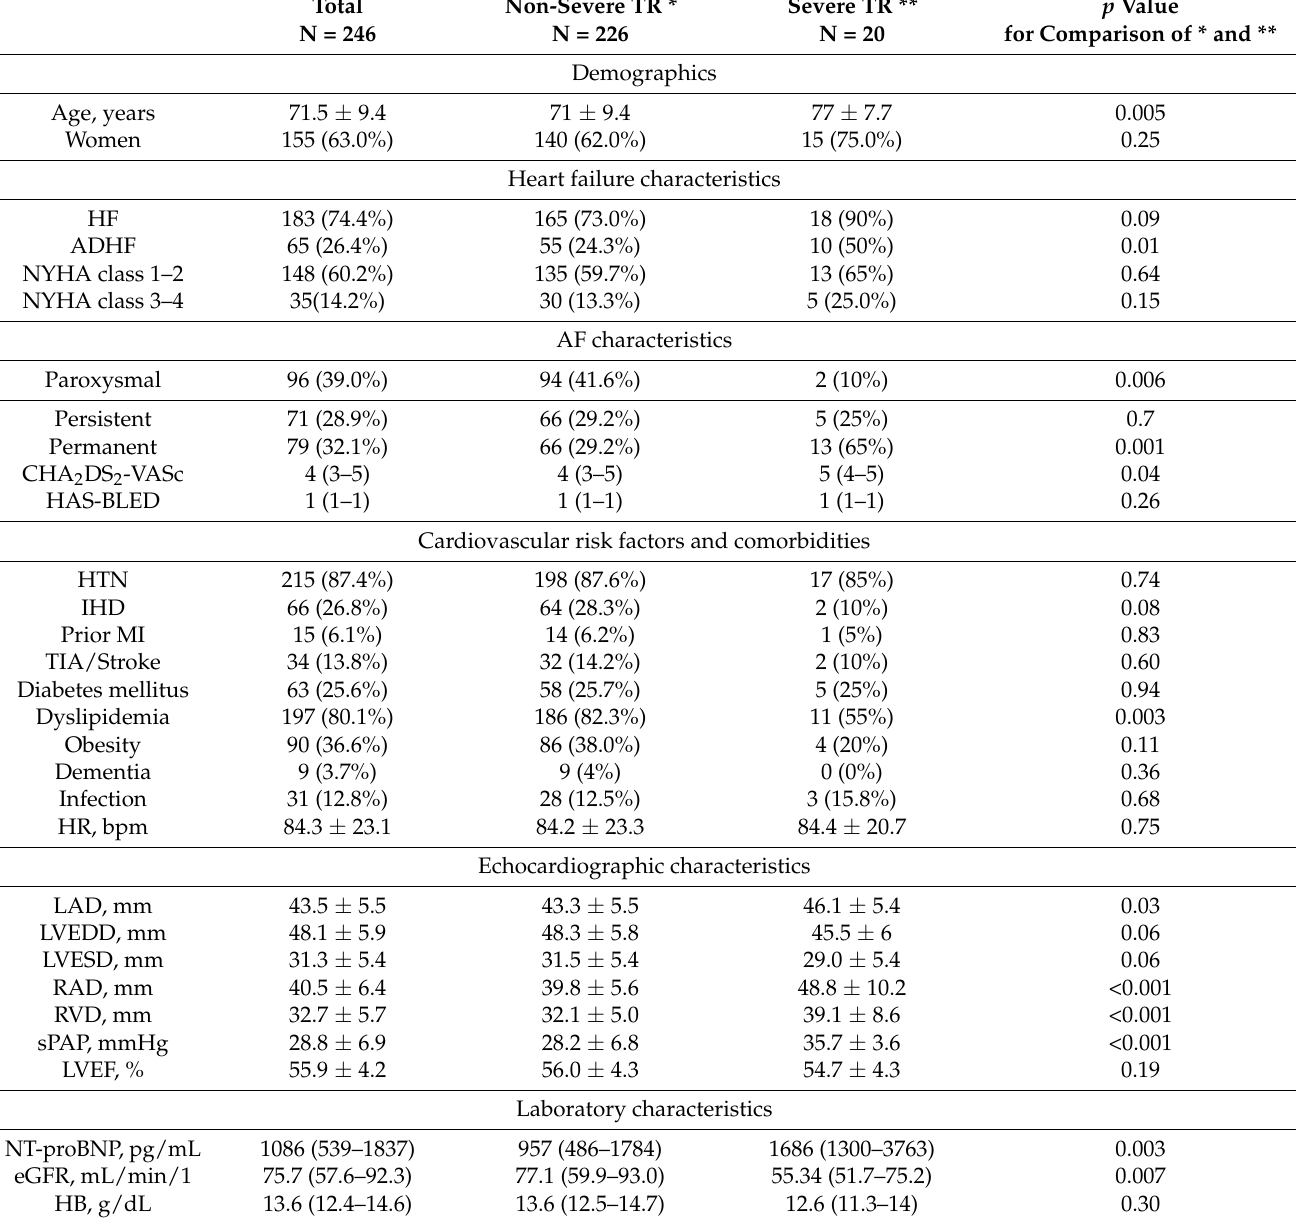
Table 1. Baseline characteristics of the study